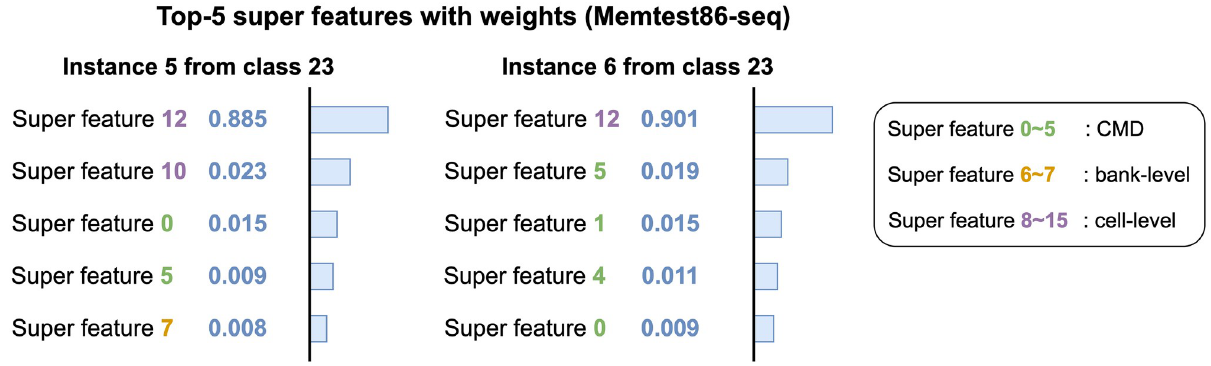
Fig 8. Interpretation of two instances for class 23 from Memtest86-seq dataset. Both instances are correctly classified as class 23. A cell-level super feature 12 and CMD super features commonly give a positive impact on the results.